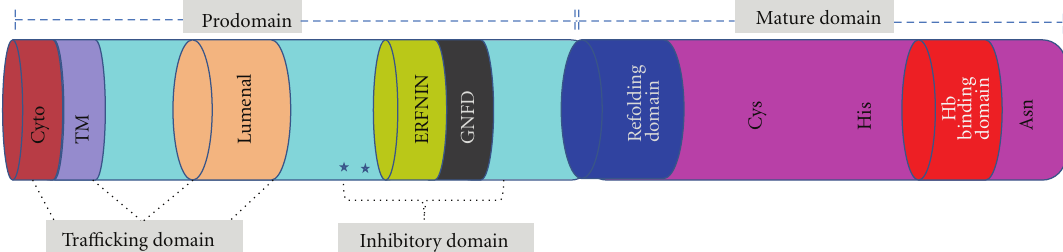
Figure 2: Domains of falcipain-2: schematic diagram showing di ff erent domains of falcipain-2. Prodomain is made up of cytoplasmic, transmembrane, luminal, and inhibitory domains. The mature domain has refolding domain, hemoglobin (Hb) binding domain, and catalytic triad residues (Cys, His, Asn). The conserved residues (Phe 165 , Phe 168 ) present in inhibitory domain are labeled with asterisks.